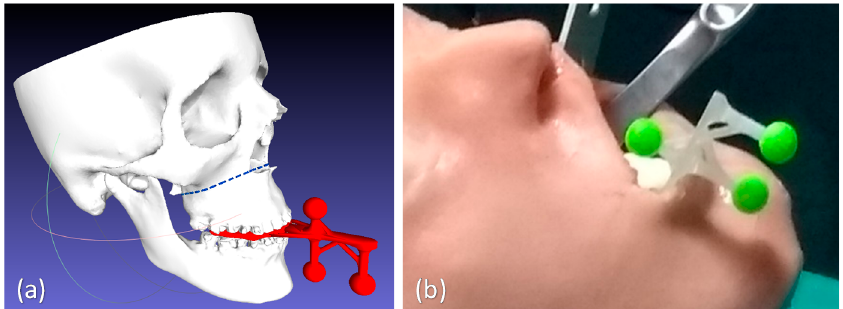
Figure 4. The virtual ( a ) and the 3D-printed model ( b ) of the task-oriented maxillofacial tracker designed for providing optimal tracking and registration during Le Fort 1 osteotomy task.